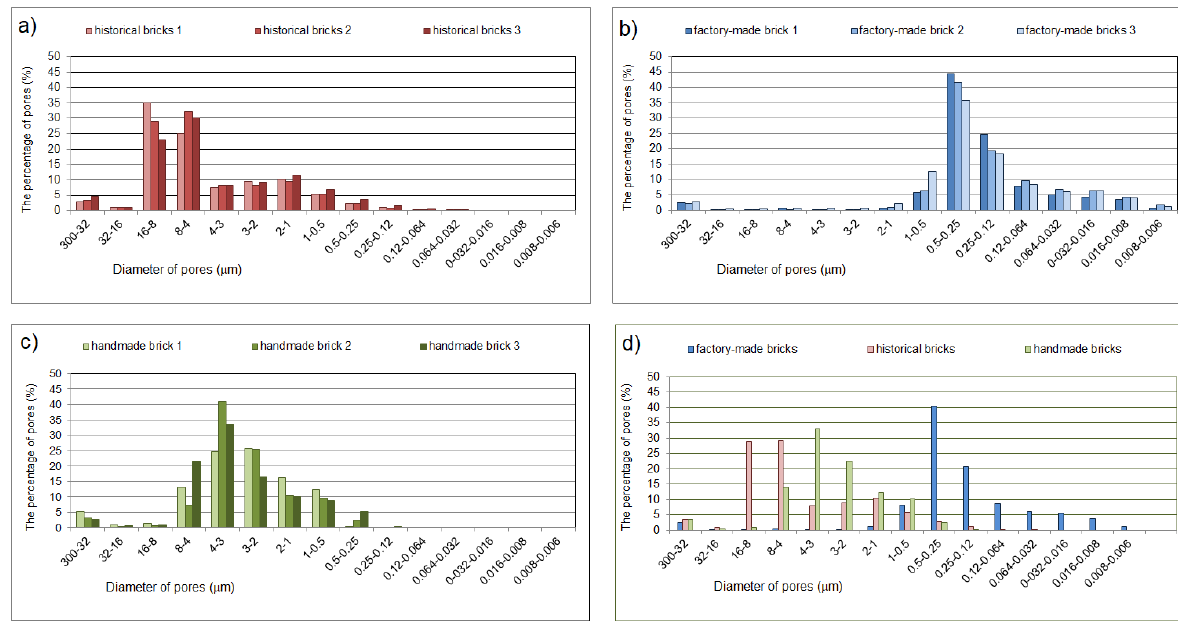
9 of 17 Figure 4. The appearance of non-resistant bricks after the freeze-thaw study: ( a ) complete damage (historic brick), ( b ) damage in the form of delamination (factory-made brick) . A brick is resistant to freeze-thaw cycles if, after 25 cycles, the number and size of the edge, angle damage, and cracking on the surfaces is lower than specified in PN-B- 12012:2007. Taking into account the criteria specified by this standard, only the hand-